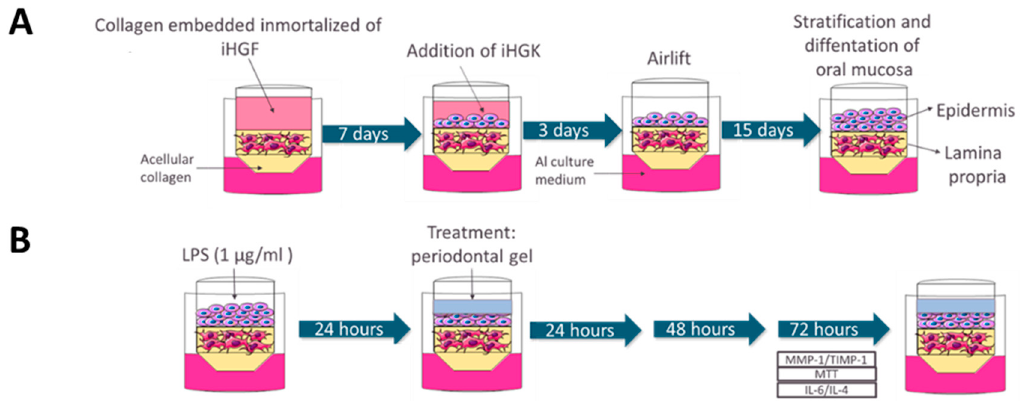
Pharmaceutics 2021 , 13 , x Figure 1. Experimental design for testing periodontal gels on 3D gingival tissue equivalents (GTE). ( A ) Experimental setup 3D of GTE and ( B ) stimulation of GTE with LPS and periodontal gel treatment.